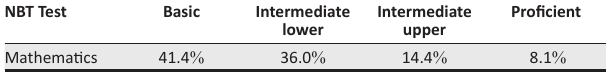
TABLE 2: Distribution across benchmark levels for 2012 national benchmark test mathematics